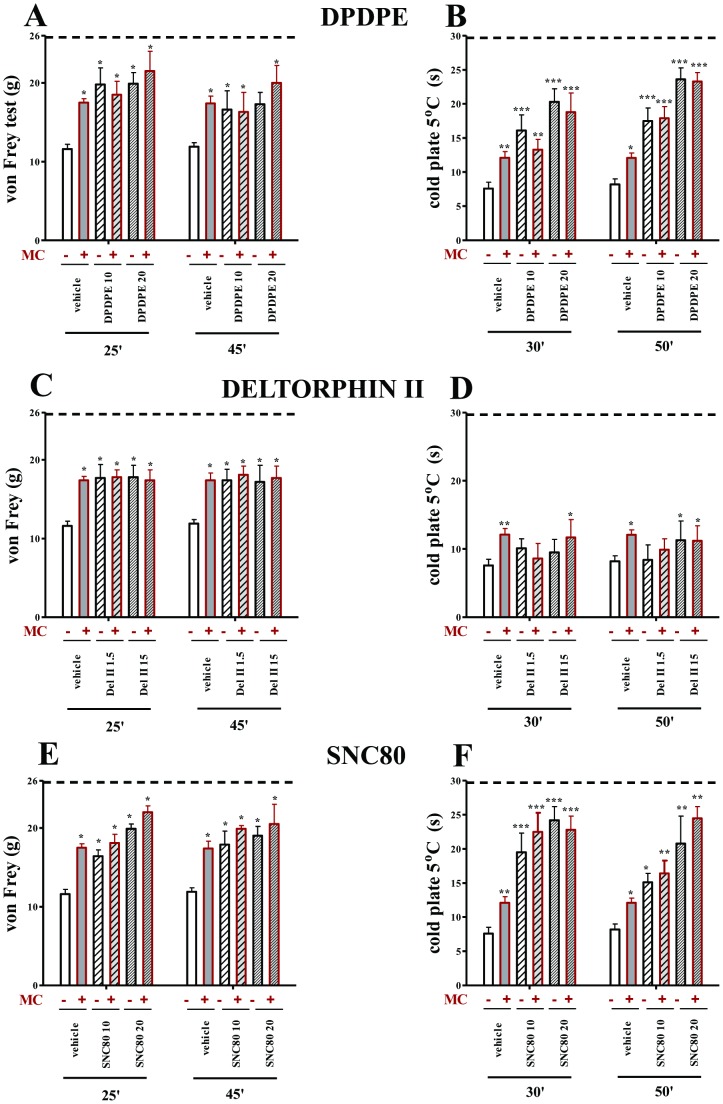
The effects of DPDPE, deltorphin II and SNC80 on vehicle- and minocycline-treated CCI-exposed rats.The response to DPDPE, deltorphin II and SNC80 was measured 25 and 45(A, C, E) and 30 and 50 minutes after administration by the cold plate test (B, D, F). Minocycline (MC; 30 mg/kg; i.p.) was administered intraperitoneally pre-emptively 16 h and 1 h before CCI, and then repeatedly twice daily for 7 days. Vehicle-treated and minocycline-treated rats received intrathecal DPDPE (10; 20 µg/5 µl), deltorphin II (del II; 1.5; 15 µg/5 µl) or SNC80 (10; 20 µg/5 µl) one hour after the last morning administration on day 7 after CCI. The data are presented as the mean response ± S.E.M. (8–16 rats per group). The results of the experiments were statistically evaluated using ANOVAs. The differences between the treatment groups throughout the study were further analysed with Bonferroni's post-hoc tests. *P<0.05, **P<0.01 and ***P<0.001 indicate significant differences compared with vehicle-treated CCI-exposed rats. Dotted line is a value for naïve animals (for von Frey test 25.8 g; for cold plate test 29.7 s).